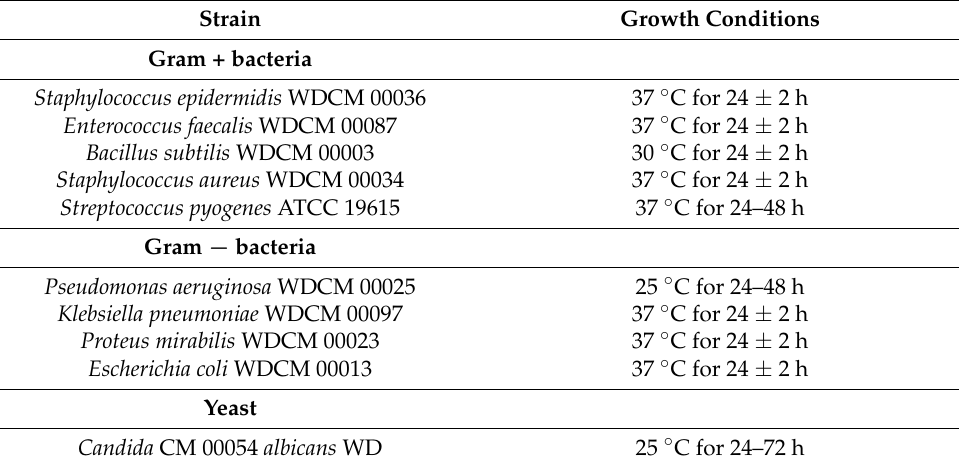
Table 1. Strains tested and growth